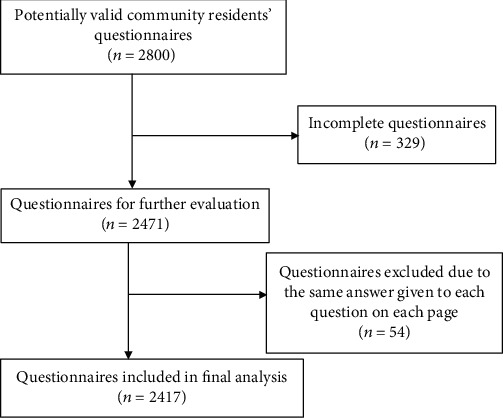
Flowchart showing the selection of valid questionnaires.